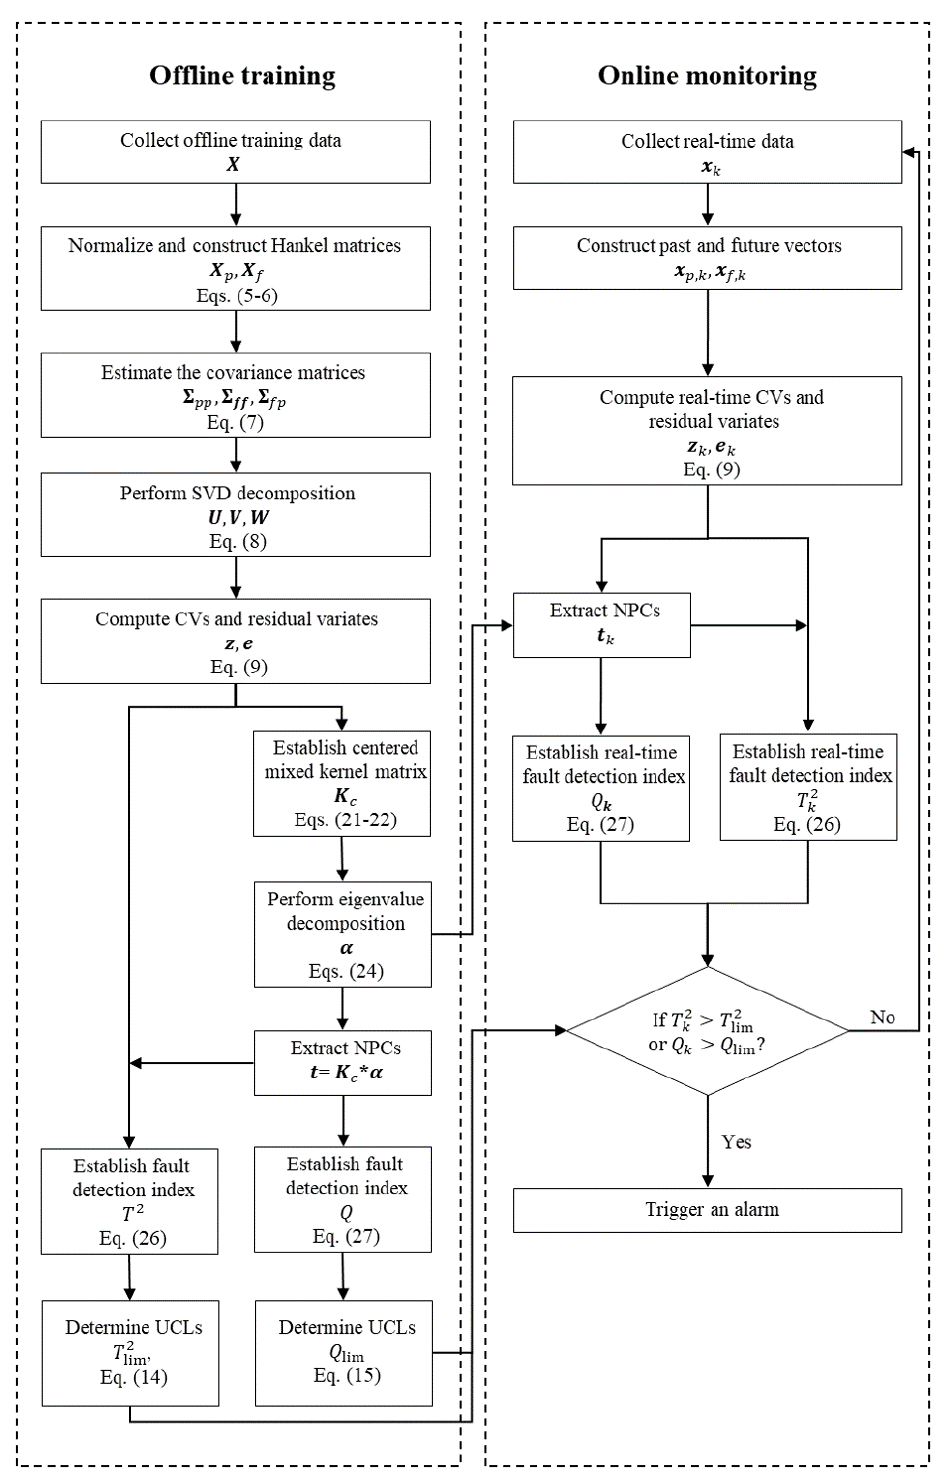
Figure 2. CVKA algorithm